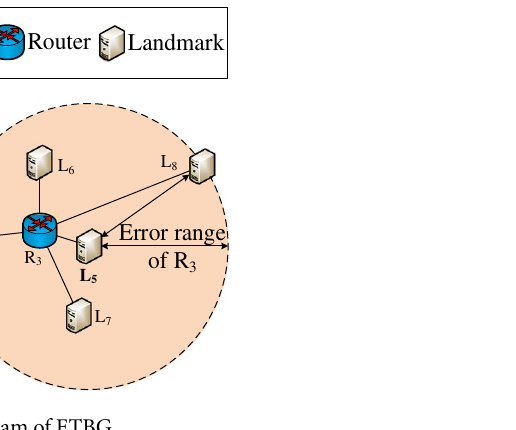
Figure 1. Geolocation schematic diagram of